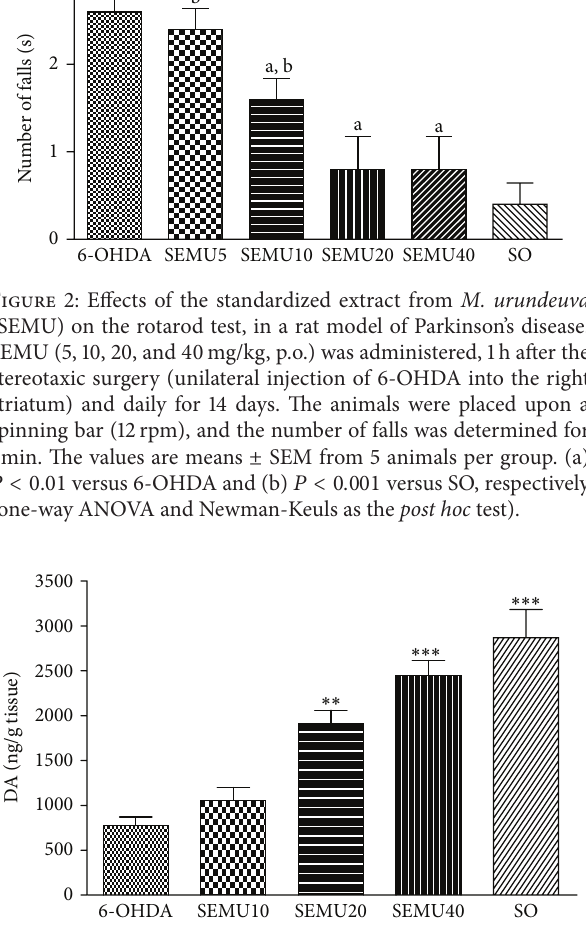
Figure 3: Effects of the standardized extract from Myracrodruon urundeuva (SEMU: 10, 20, and 40 mg/kg, p.o.) on dopamine (DA) levels in the right striatum. The drug was administered, 1h after the stereotaxic surgery (unilateral injection of 6-OHDA into the right striatum) and daily for 14 days. The values are expressed as means ± SEM from 5 to 12 animals per group. ∗ 𝑃 < 0.05 ; ∗∗ 𝑃 < 0.01 ; ∗∗∗ 𝑃 < 0.001 versus 6-OHDA (one-way ANOVA and the Newman- Keuls as the post hoc test).